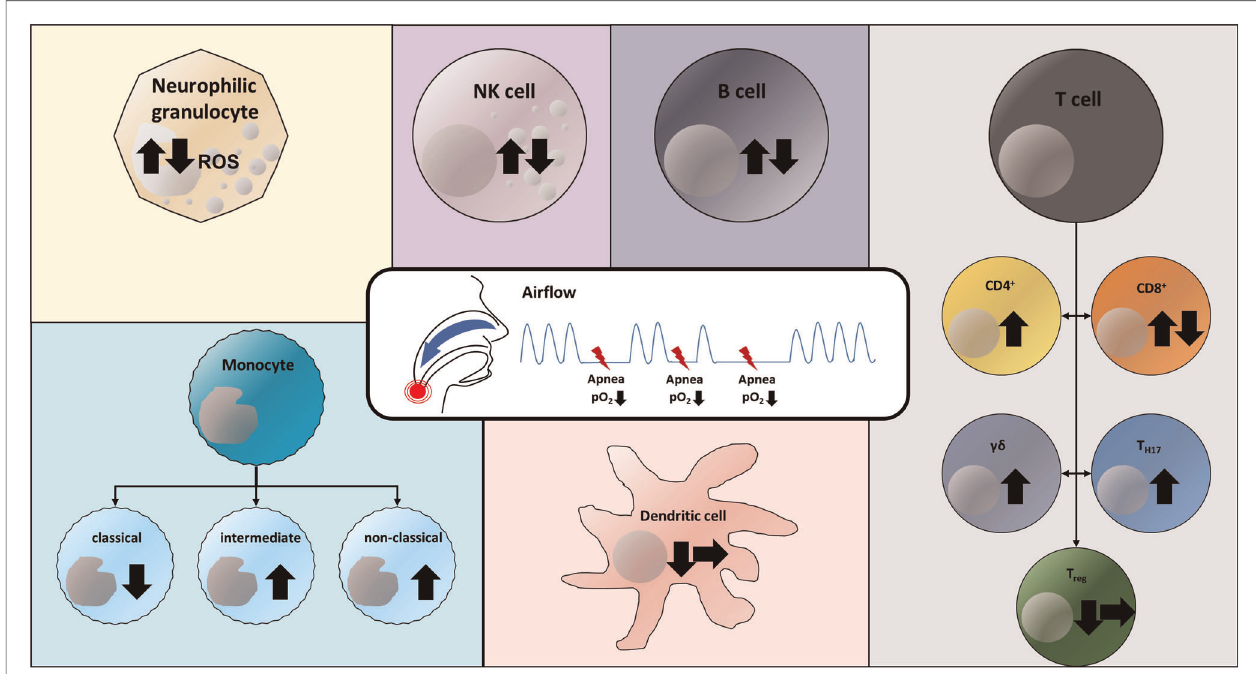
FIGURE 1 | Versatile effects of obstructive sleep apnea and chronic intermittent hypoxia on the cellular immune system. Arrow up: Increase in cell population; Arrow down: Decrease in cell population; Arrow to right: No change in cell population (in OSA patients compared to respective control group). Both increased and decreased levels of reactive oxygen species (ROS) in neutrophil granulocytes have been reported (37, 38). Similarly, there are both observations on NK, NKT, and B cells describing an increase and a decrease in the respective cell population (3, 31, 32, 36, 44). CD4 + effector T cells have been detected at increased levels in OSA patients (21). CD8 + T cells were found in both increased and decreased concentrations compared with the corresponding control group (31 – 33). Both T H17 cells and γδ T cells were detected in increased concentrations in the blood of OSA patients and in cell culture experiments, respectively (28 – 30). Regulatory T cells have been described in reduced numbers in OSA patients (28) or at unaltered population levels (31). Studies describe that chronic intermittent hypoxia both has no effect on the population of dendritic cells (31) and leads to a decrease of these (34). Within the monocyte subpopulations, a decrease in classical monocytes and an increase in CD16 + subtypes (intermediate, non-classical) have been documented in OSA patients